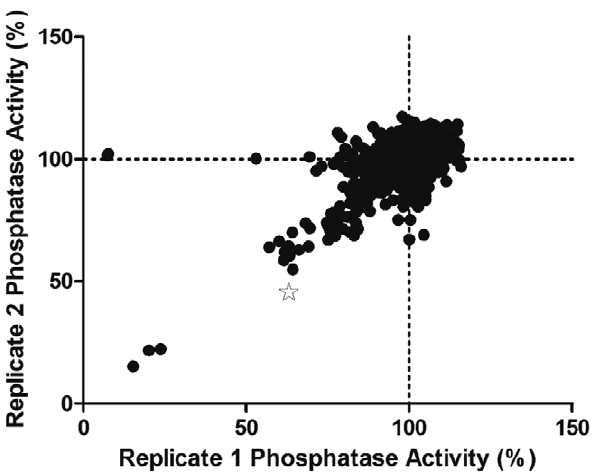
Figure 1 . Screening of Marine Extract Library for inhibitors of CpsB activity. The ability of extracts to inhibit His 6 CpsB dephosphor- ylation of p NPP in 1 M Tris pH 8.0 with 1 mM MnCl 2 was investigated in 96 well trays at 37 u C. Shown is a plot of the two screening replicates reported as % phosphatase activity relative to the average of particular screening plate. The star represents the extract which produced the pure compound of interest.